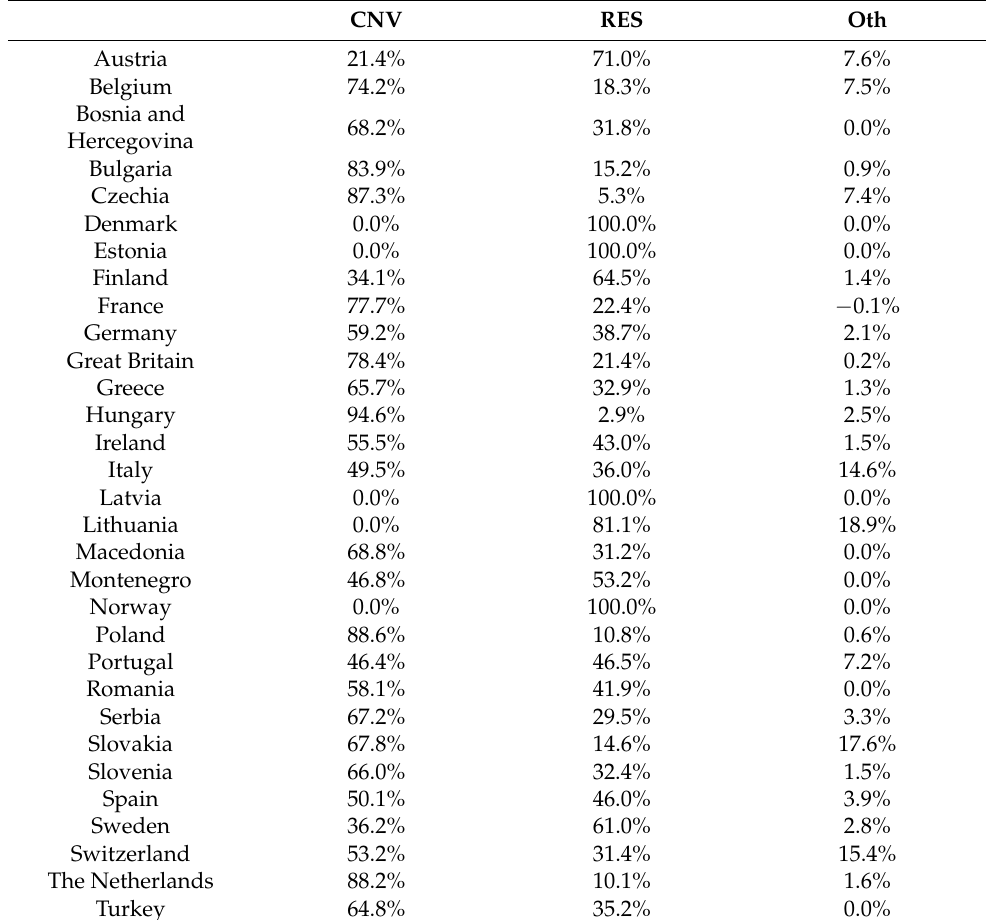
Table 4. Energy mix-calculated on the averaged production of 2018–2021. Source: own work on the basis of